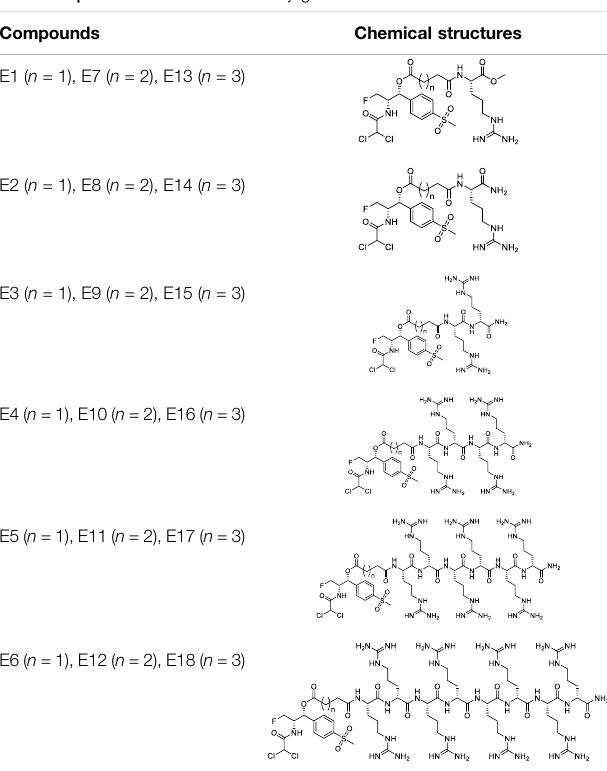
TABLE 1 | Chemical structures of